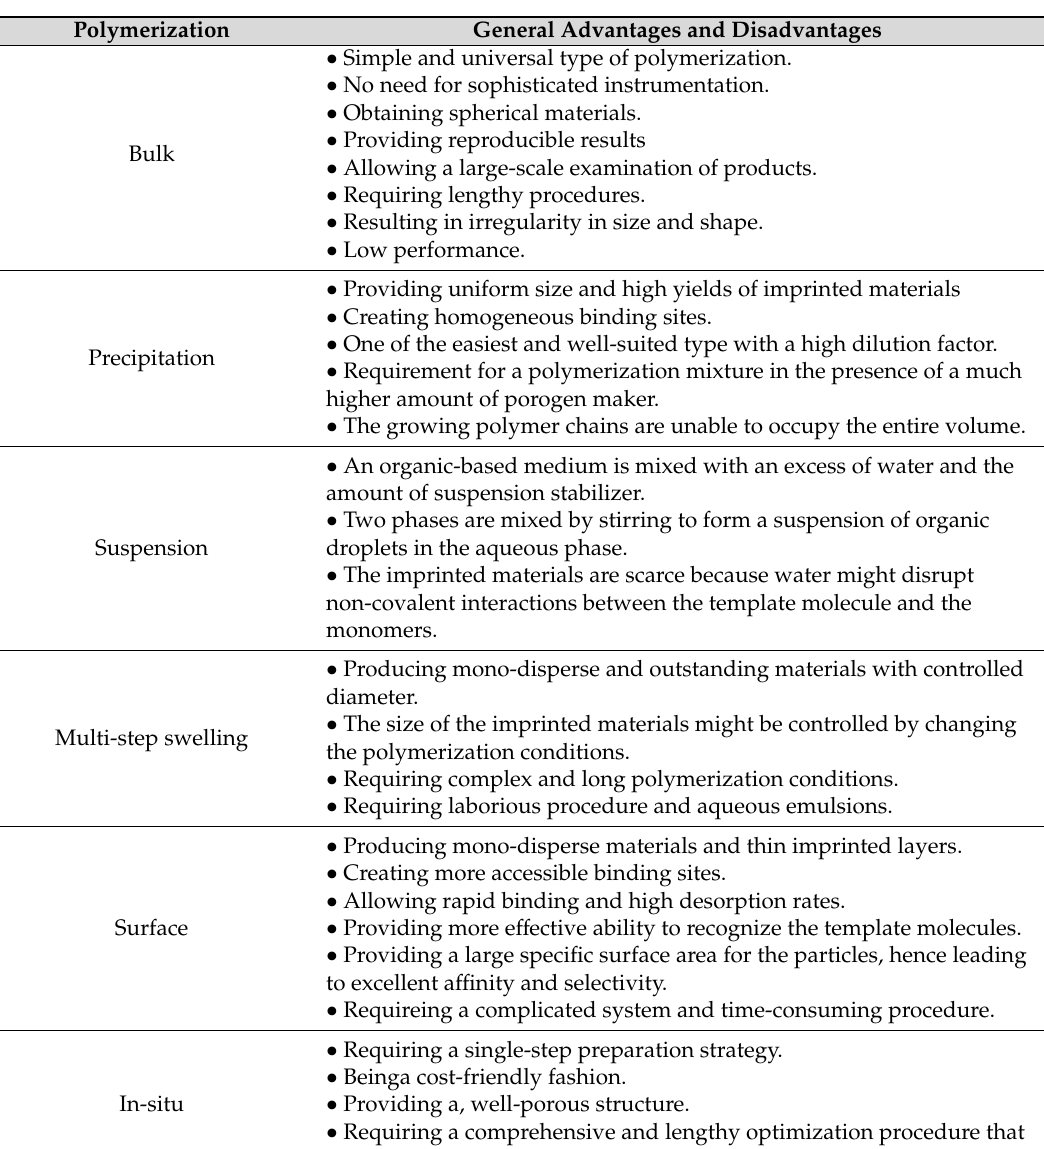
Table 1. The comparison of the di ff erent polymerization types. Republished with permission from Rutkowska et al. [62]